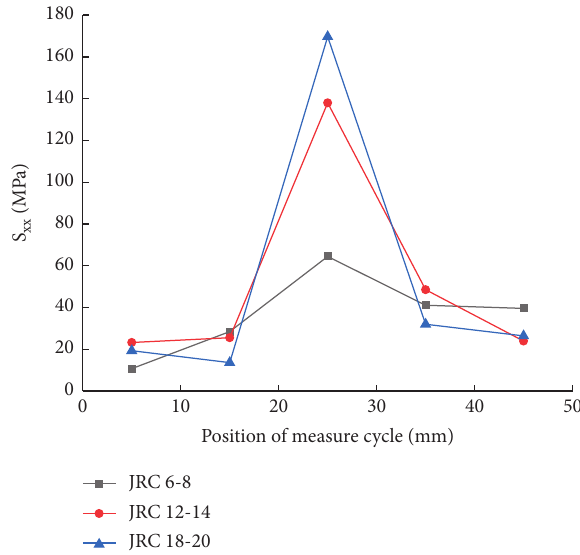
Figure 13: Distribution curves of S